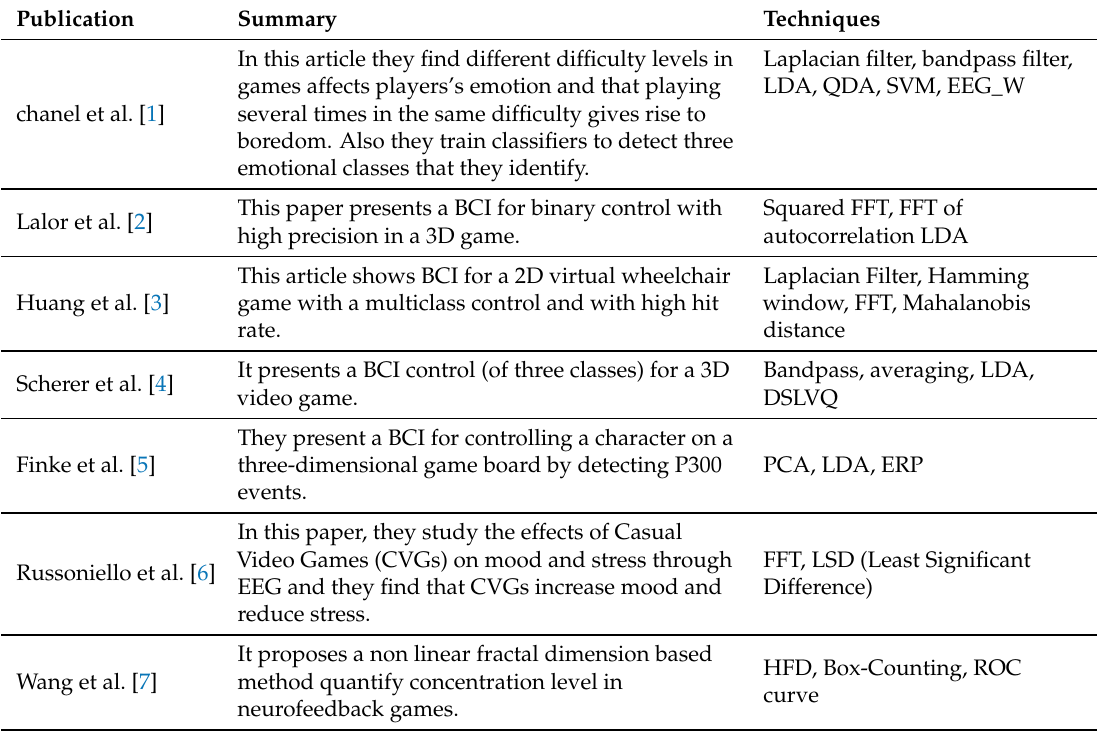
Table 1. Selected articles and summarized content. They are descendently ordered by the number of